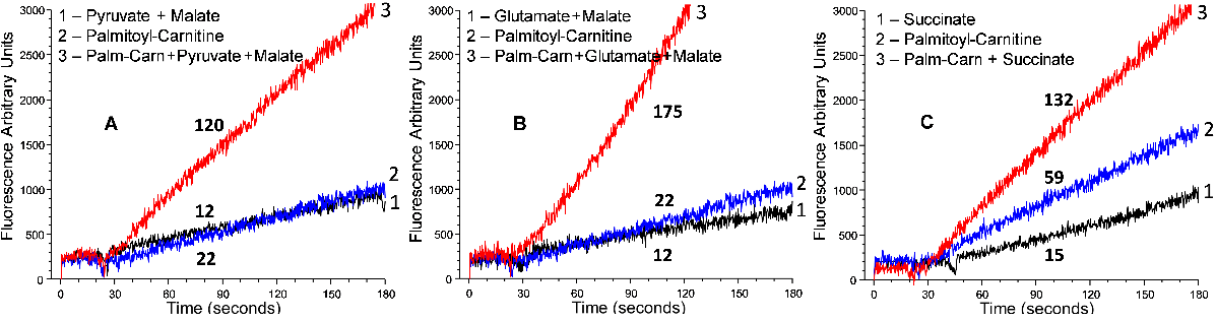
Figure 1. Production of superoxide radicals by rat heart mitochondria oxidizing palmitoyl-carnitine . Designations: 1 . supporting substrate only; 2 . palmitoyl-carnitine only, and 3 . palmitoyl-carnitine + supporting substrate. Substrates : ( A )—pyruvate 2.5 mM + malate 2 mM, ( B )—glutamate 5 mM + malate 2 mM, and ( C )—succinate 5 mM. Experimental conditions are described in refs [57,60]. The numbers at the lines are the rates of ROS production in picomol of H 2 O 2 per minute per mg of mi- tochondrial protein.